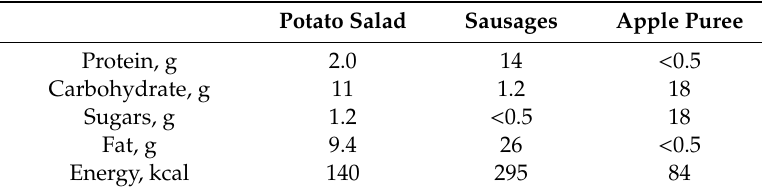
Table 1. Macronutrient composition and energy density of the foods (per 100 g) that were served during the standardized